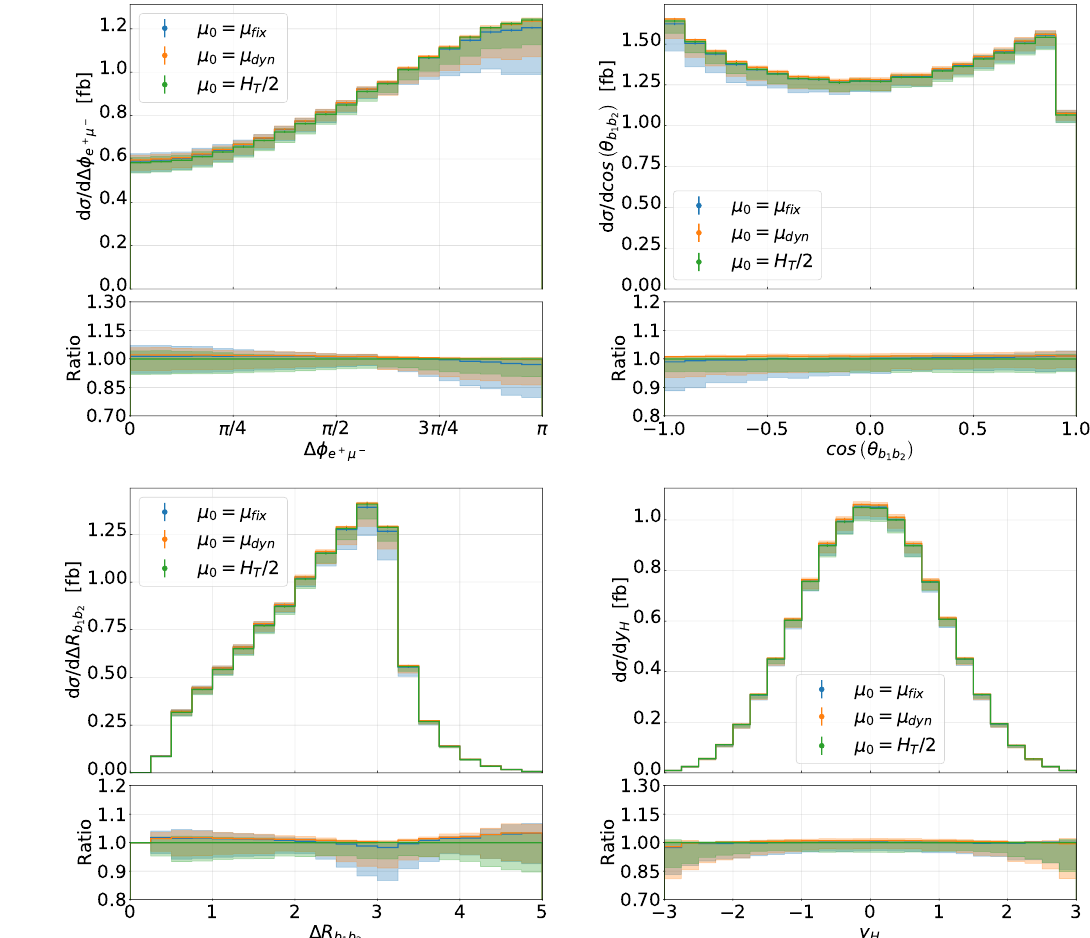
, cos ( θ b ) , ∆ R b e + µ − √ 1 b 2 1 b 2 s = 13 TeV. Results are presented for